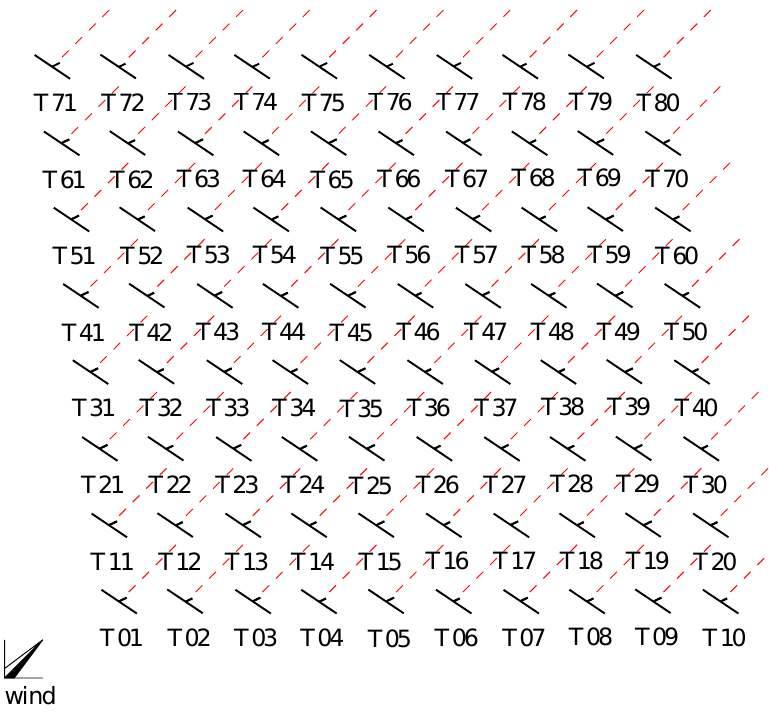
Figure 6. Horns Rev wind farm of 80 turbines facing a main wind speed with 45 ◦